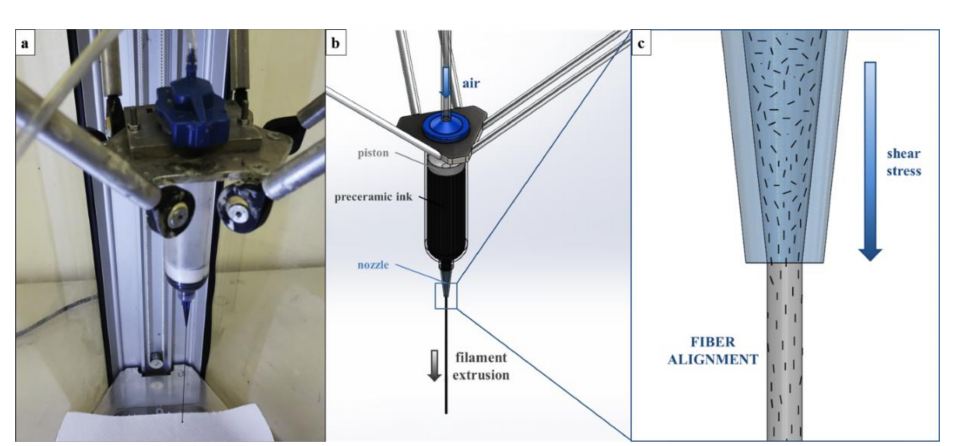
Figure 1. Overview of the filament production process: ( a ) filaments extruded with a 410- µ m nozzle; ( b ) schematics of the extrusion process; ( c ) magnification of the nozzle tip, showing the fiber alignment in the extrusion direction driven by the shear stress generated by the process (fibers are drawn to